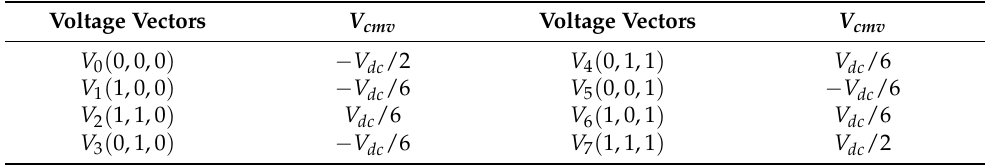
Table 2. Common-mode voltage of the space